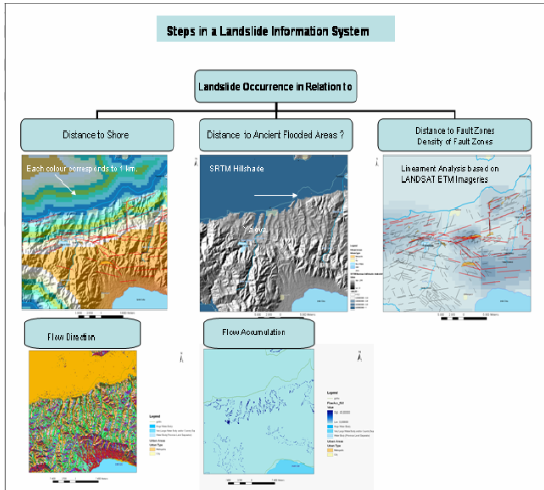
Figure 3. SRTM and ERS satellite radar data from the North